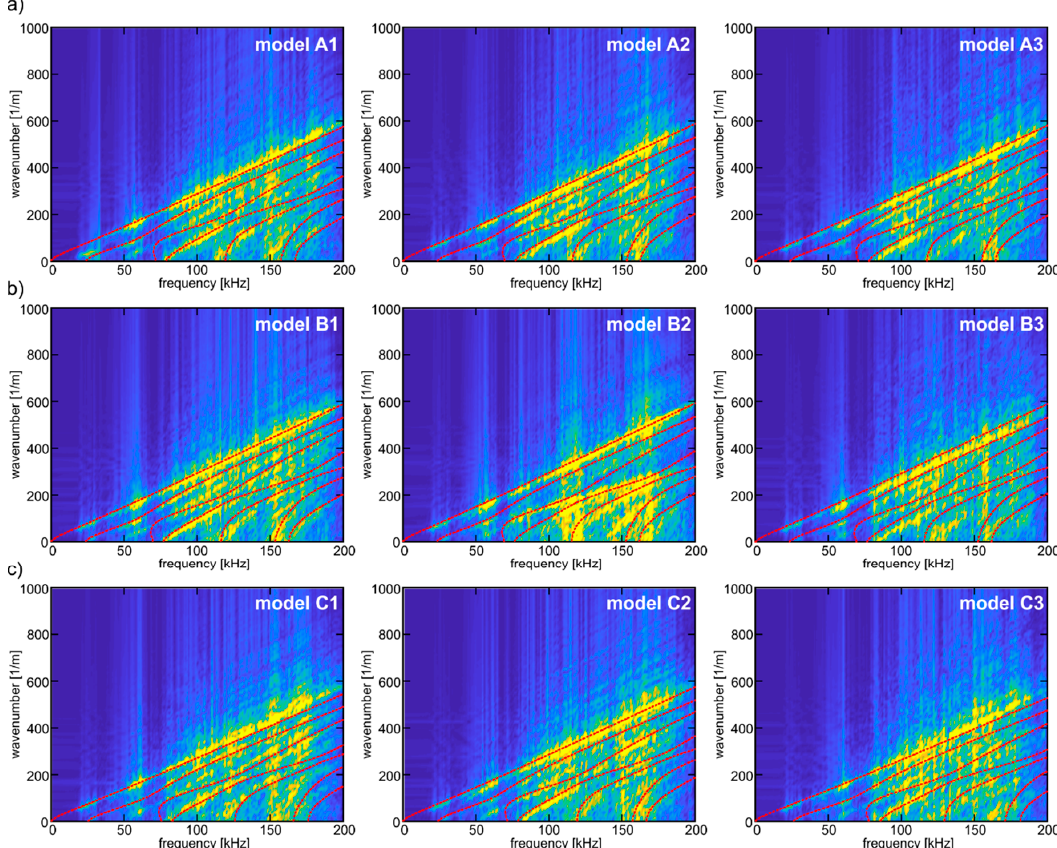
Figure 10. Wavenumber–frequency maps determined for numerical models of heterogeneous concrete plates: ( a ) group A; ( b ) group B and ( c ) group C.